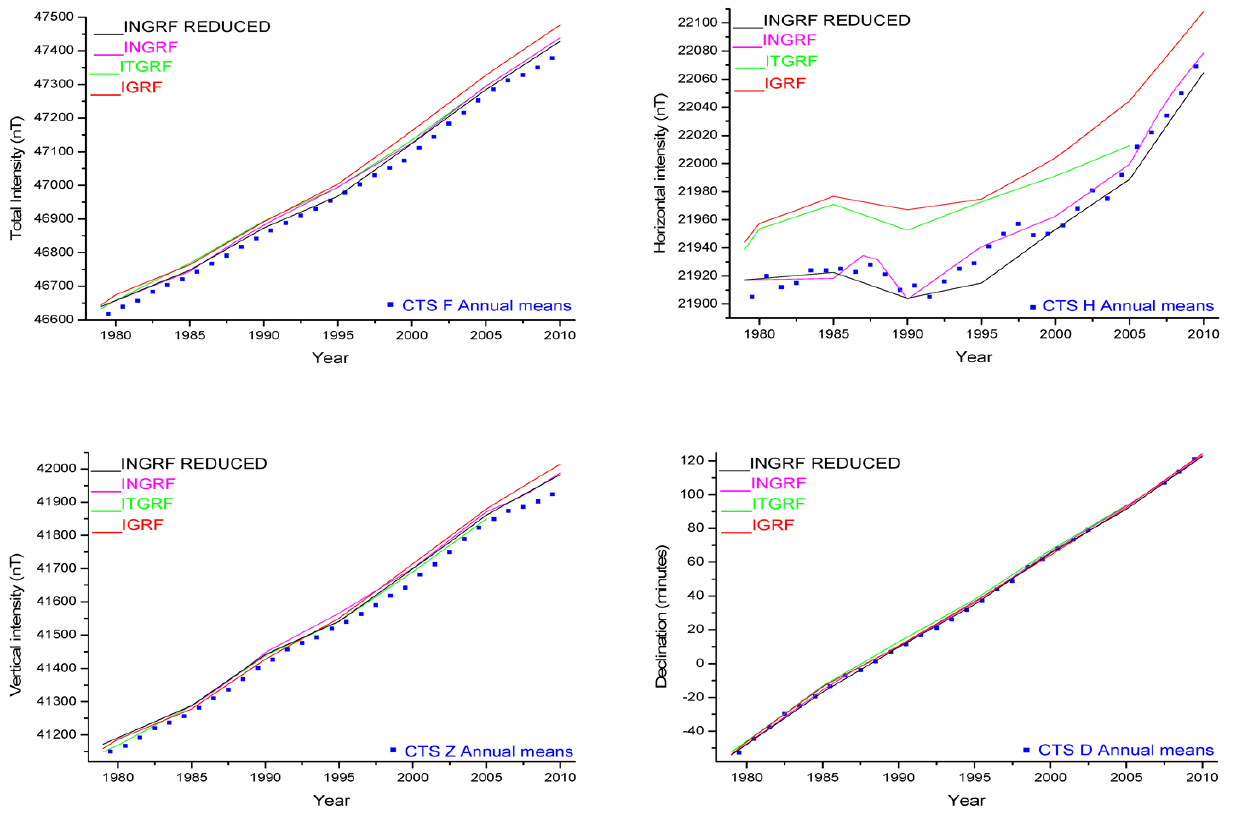
Figure 7. Annual mean values of F, H, Z, D computed at Castello Tesino observatory (squares) together with the values predicted by various models (coloured lines).